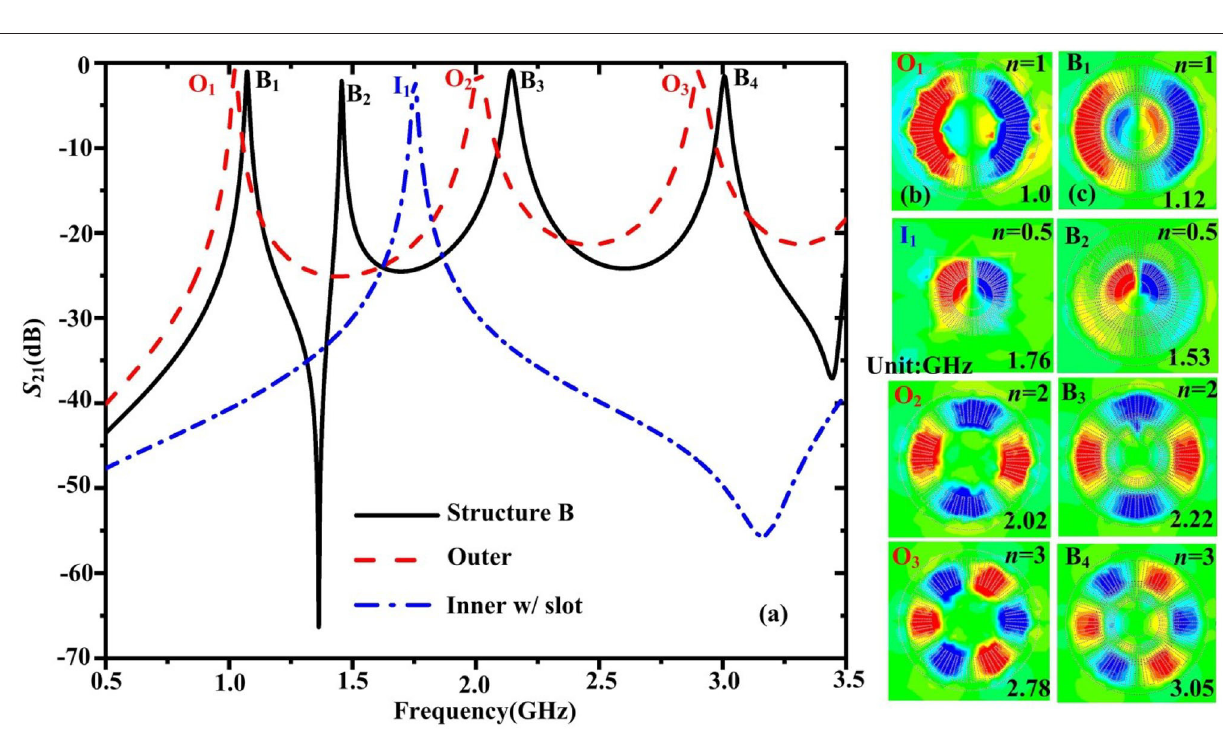
slit in the corrugated ring. The structure is equivalent to